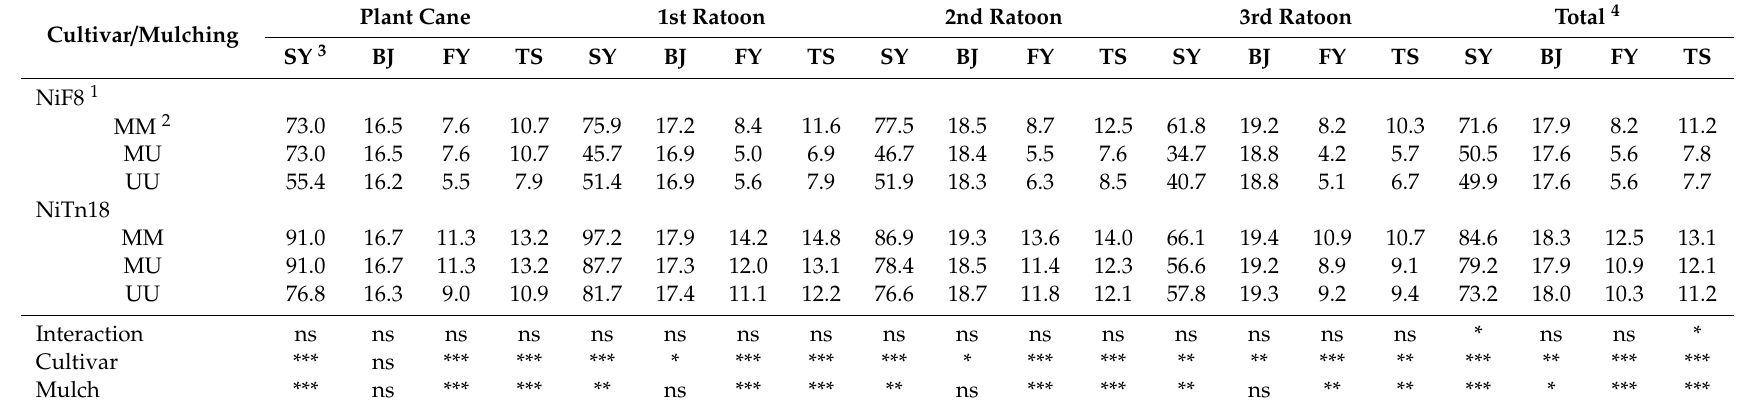
Table 2. ANOVA and multiple comparisons by the Sche ff é method performed on harvest data of plant cane and three ratoons. Cultivar /